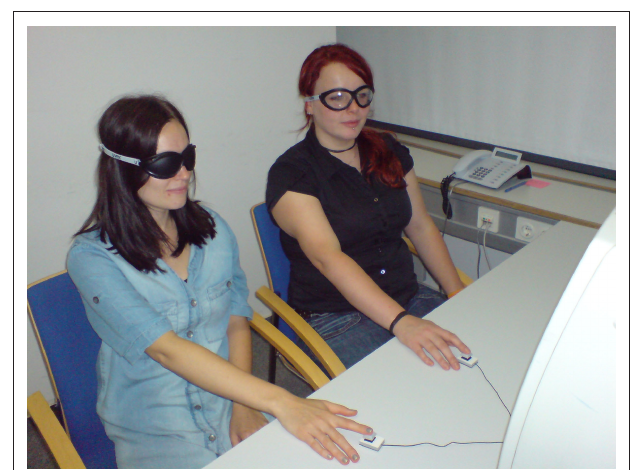
Figure 3 | goggles used in the blindfolded (see left participant) and seeing conditions (see right